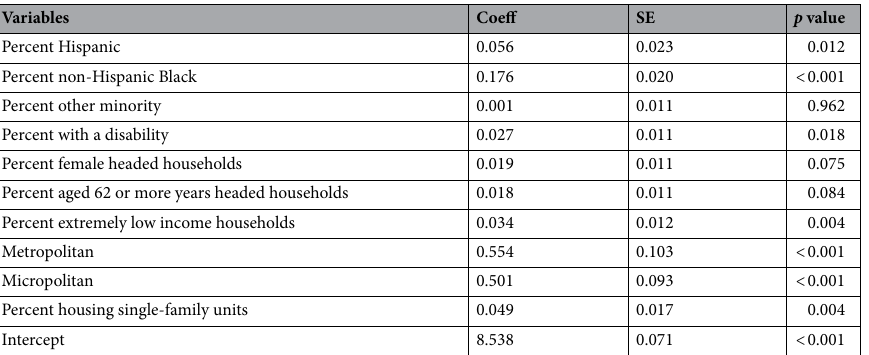
Table 4. Multivariable GEEs for predicting PM 2.5 concentration around public housing developments. N = 6685 PHDs with complete data for all independent variables. Model specifications are gamma with identity link with an exchangeable correlation matrix with controls for clustering in terms of city in which PHD is located (3337 clusters). SE is standard error and all p values are based on Wald Chi-Square test. Independent variables were